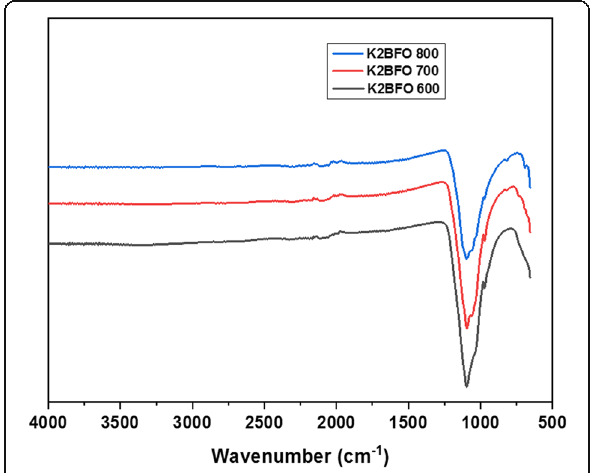
Fig. 2 ATR – FTIR spectra of the powder 600 – 800°